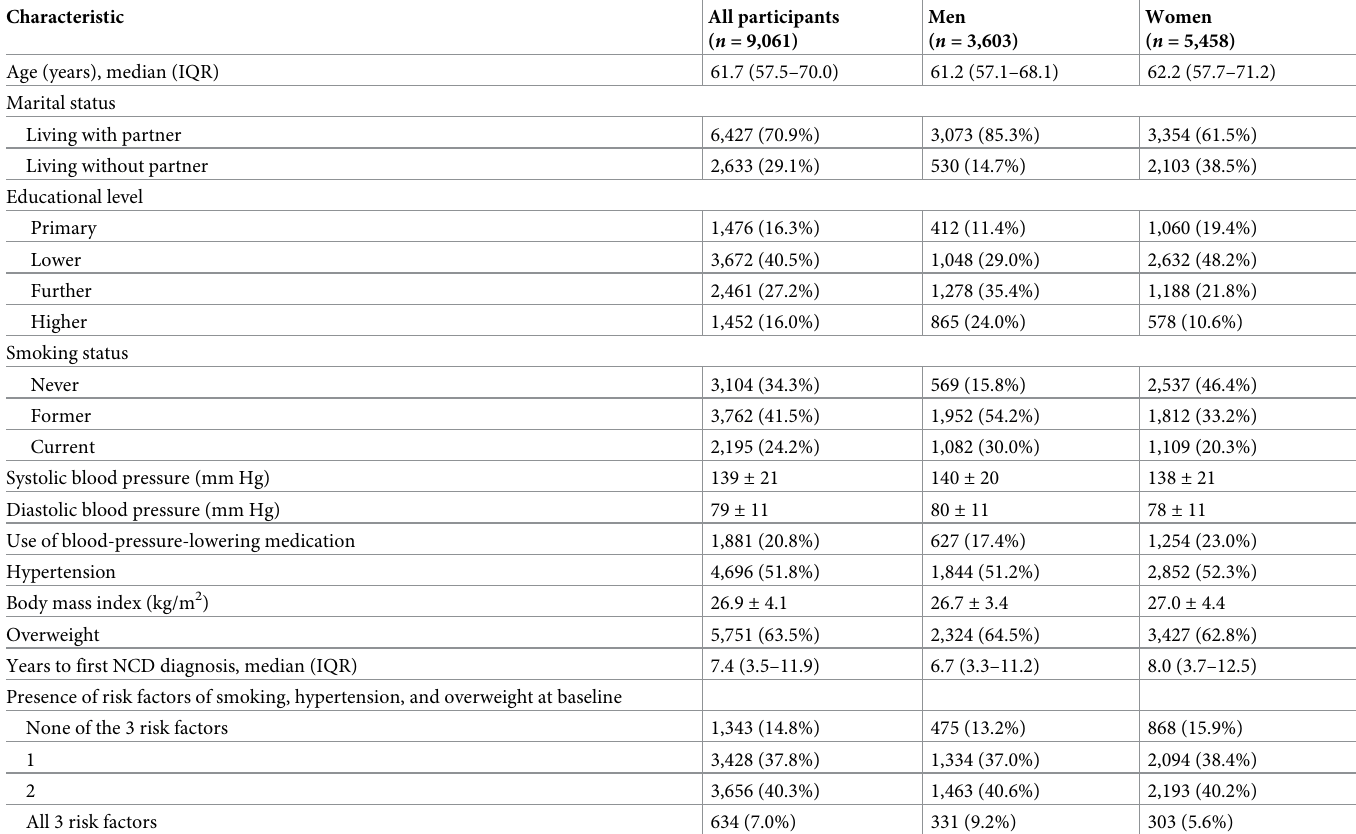
Table 1. Baseline characteristics of the study